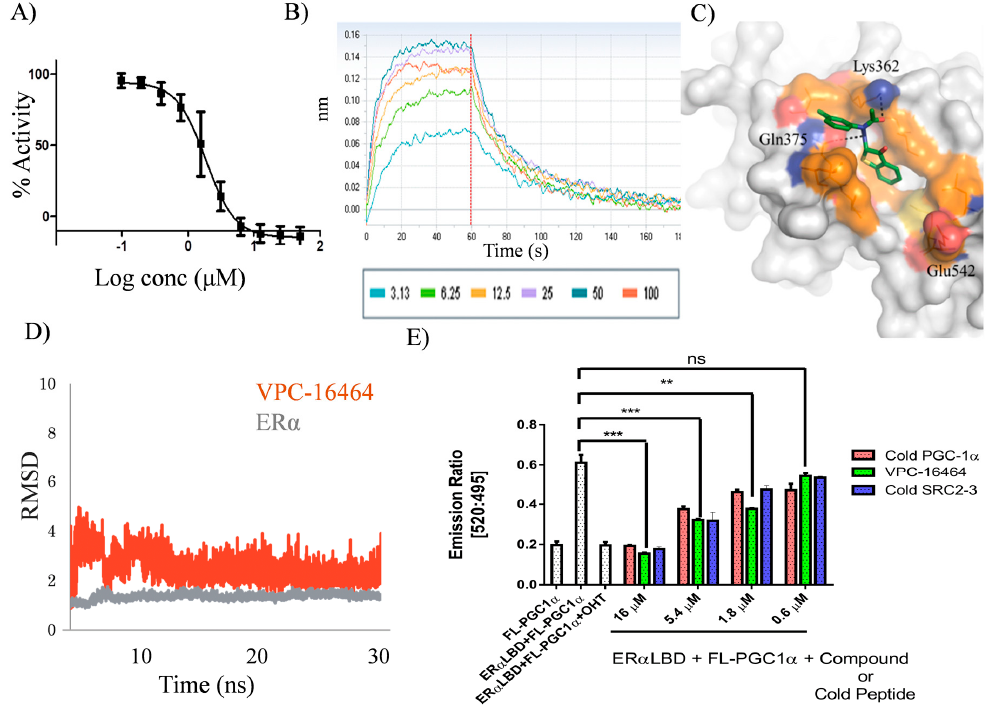
Figure 2. In silico predicted and experimental profile of VPC-16464. ( A ) Dose-response curve illustrating the inhibition effect (IC 50 2.7 µM) on ER α transcriptional activity in T47DKBluc cells using an estrogen-responsive luciferase reporter assay. Data points represent the mean of three independent experiments performed in triplicate and expressed as the percentage of luciferase activity relative to the 17 β -estradiol (E2) control. Error bars represent the standard error of mean (SEM) for 3 independent experiments performed in triplicates. Data were fitted using log 10 of the concentration (conc) of the inhibitors vs. response with GraphPad Prism 6. ( B ) Biolayer interferometry (BLI) dose-response curves (3–100 µM) reflecting the direct binding of VPC-16464 to biotinylated ER α ligand binding domain (LBD) immobilized onto a streptavidin sensor. ( C ) The most stable conformation of VPC-16464 obtained from molecular dynamics (MD) simulations (green). H-bond interactions with the AF2 site residues are shown in black dotted lines. ( D ) RMSD curves demonstrating the individual stabilities of ER α and VPC-16464 upon complex formation during MD simulations. The orange curve shows that the ligand adopts a stable conformation in the AF2 pocket after 10 ns of simulation time. The grey curve shows that the ER α protein remains stable upon ligand binding. ( E ) VPC-16464 blocks the interactions between ER α -LBD and the LXXLL (L, leucine; X, any amino acid) motif containing fluorescein-peroxisome proliferator-activated receptor- γ coactivator 1 α (FL-PGC1 α ) peptide in a dose-dependent manner as measured by the time-resolved fluorescence resonance energy transfer (TR-FRET) assay. 4-Hydroxytamoxifen (OHT) was used at a concentration of 1 µM. Error bars represent the SEM for 3 independent experiments performed in triplicates. *** p < 0.001, ** p < 0.01, unpaired t -test.